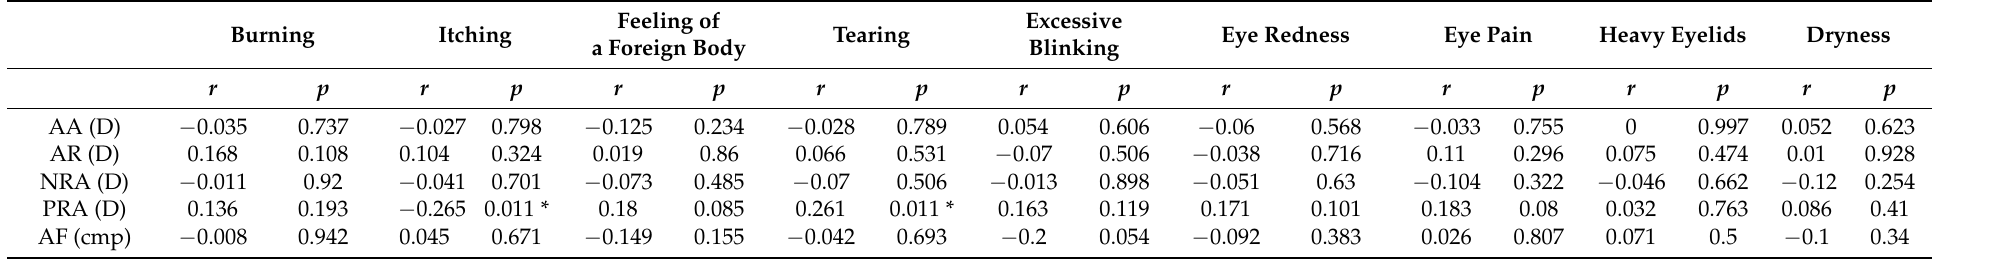
Table 3. Correlations of ocular irritation and accommodation and eye movement. Feeling of Burning Itching a Foreign Body